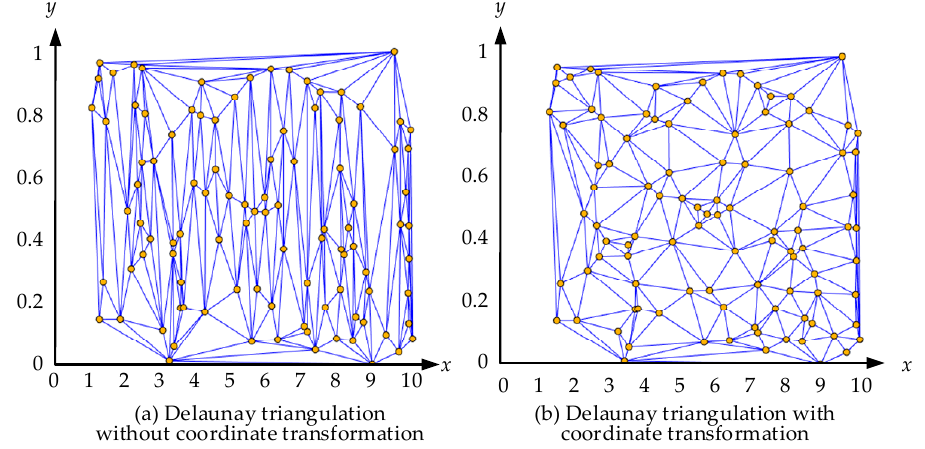
Figure 5. Delaunay triangulations generated before and after scale zooming. ( a ) Delaunay triangulation without coordinate transformation; ( b ) Delaunay triangulation with coordinate transformation.